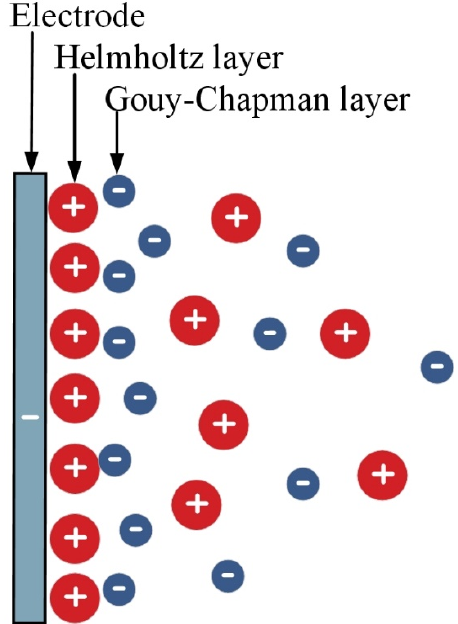
Figure 1. Schematic diagram of Gouy–Chapman–Stern model.